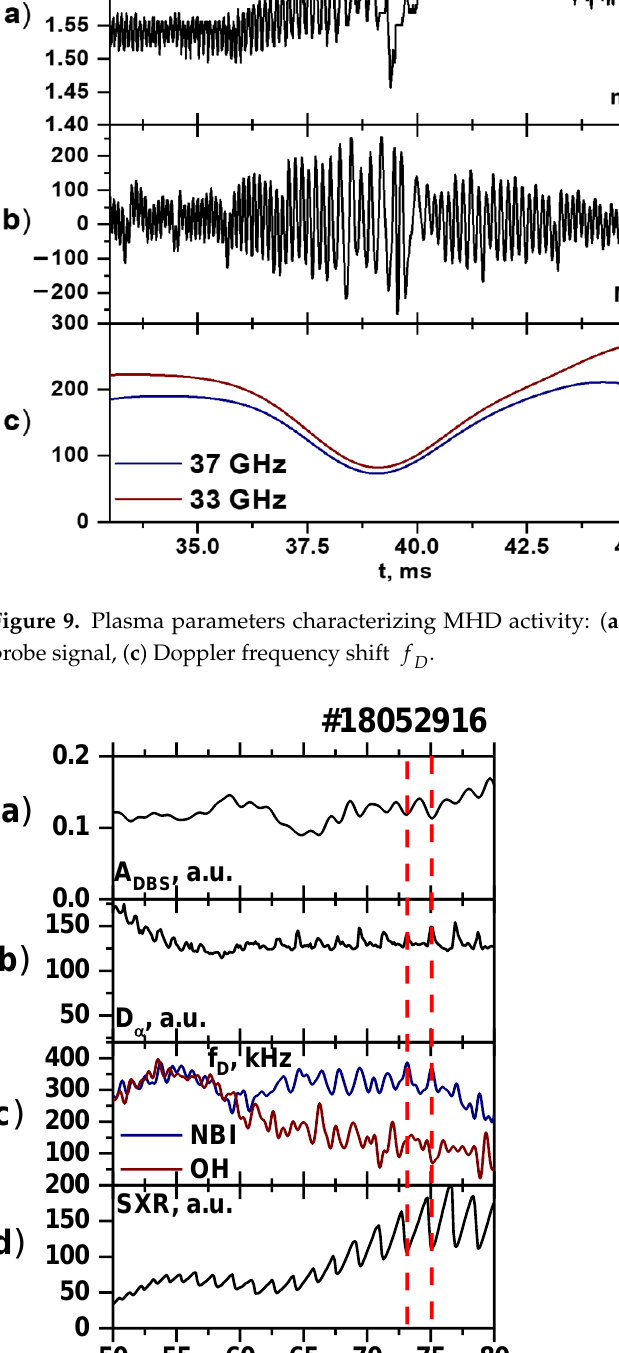
Figure 10. Plasma parameters characterizing ELM activity: ( a ) DBS amplitude, ( b ) D α signal, ( c ) Doppler frequency shift f D , ( d ) SXR signal .